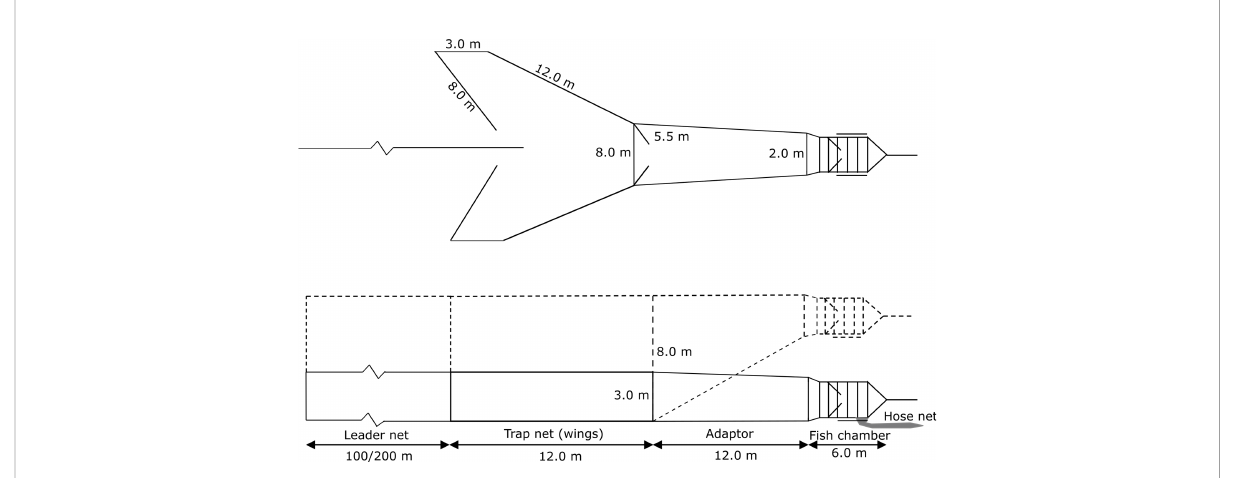
FIGURE 2 Schematic representation of pontoon-trap leader net, trap net (wings), adapter linking the trap net, pontoon fi sh chamber and hose net, from Hemmingsson et al. (2008), with measures used in traps parts within this study. The fi gure illustrates how the adaptor allows the fi sh chamber to be raised to the surface without requiring the trap net to be raised. Dashed sketch illustrates design of the fl oating fi sh chamber pontoon trap, used in trial two.